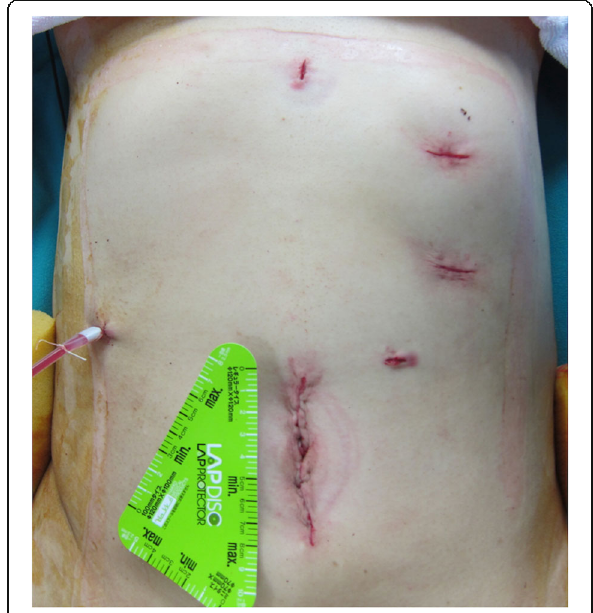
Fig. 4 Postoperative abdominal incision. The umbilical trocar incision was slightly extended and used to extract the